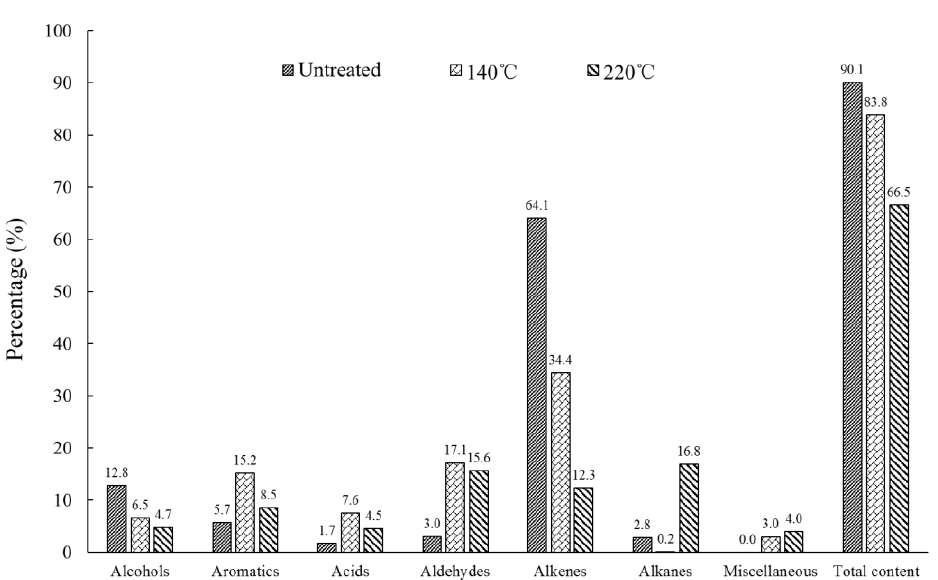
Figure 4. Contents of groups of volatile organic compounds in southern yellow pine before and after heat treatment at different temperatures. heat treatment at different